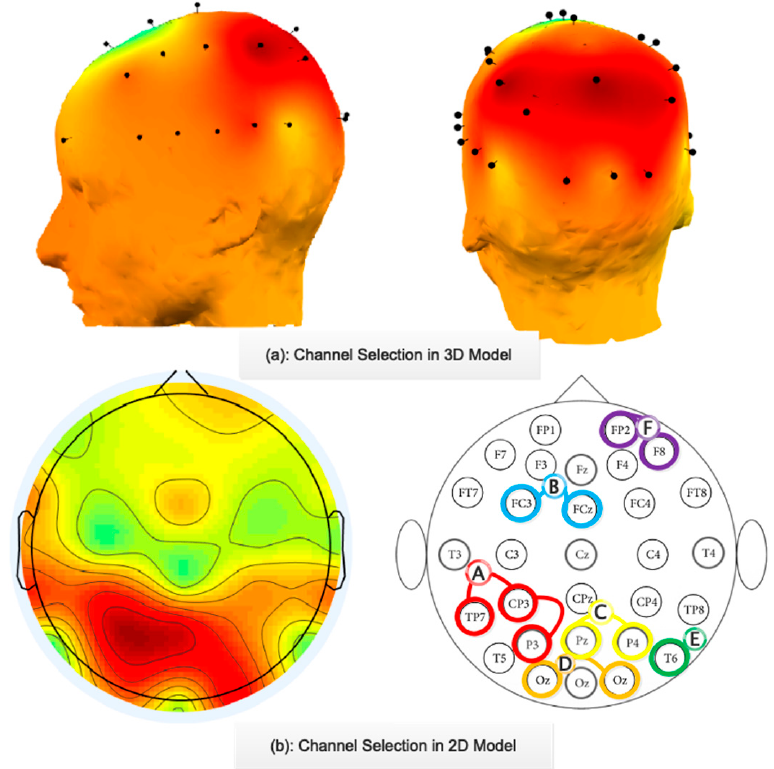
Figure 4. Select active channels in 2D and 3D models (region A = TP7, CP3 and P3; region B = FC3 and FCz; region C = Pz and P4; region D = O1 and O2; region E = T6; region F = FP2 and F8).